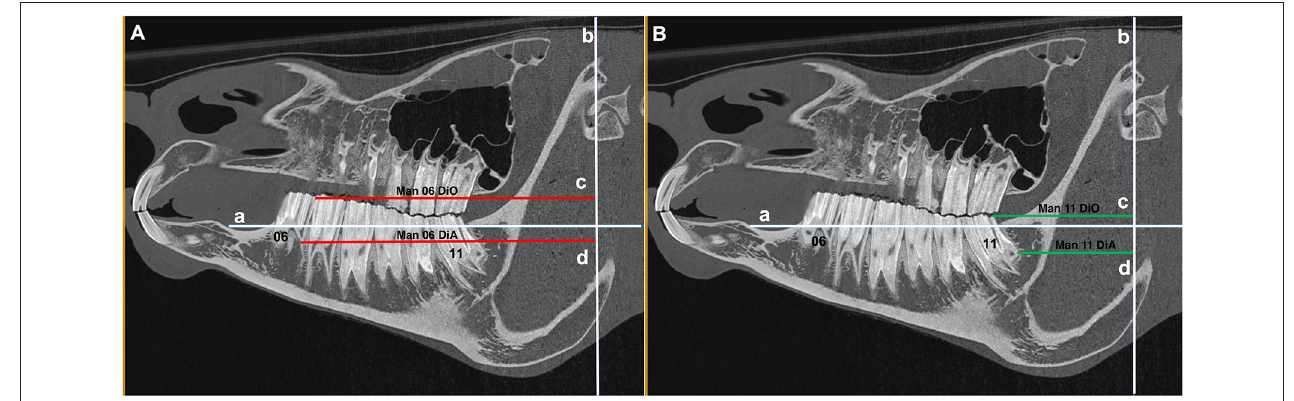
FIGURE 2 | (A) Sagittal CT image of an equine head showing line “a” that intersects the dorsal aspect of the mandibular bone immediately mesial to the mandibular second premolar (Triadan 06) tooth and the dorsal aspect of the mandibular bone immediately distal to the mandibular third molar (Triadan 11) tooth and line “b” at the level of the rostral aspect of the mandibular condyle that lies perpendicular to line “a.” The red lines “c” (Man 06 DiO) and “d” (Man 06 DiA) run from the line “b” to the distal aspect of the occlusal surface of Triadan 06 and to the distal aspect of the apex of Triadan 06, respectively. (B) Sagittal CT image of an equine head showing line “a” that intersects the dorsal aspect of the mandibular bone immediately mesial to the mandibular second premolar (Triadan 06) tooth and the dorsal aspect of the mandibular bone immediately distal to the mandibular third molar (Triadan 11) tooth and line “b” at the level of the rostral aspect of the mandibular condyle that lies perpendicular to line “a.” The green lines “c” (Man 11 DiO) and “d” (Man 11 DiA) run from the line “b” to the distal aspect of the occlusal surface of Triadan 11 and to the distal aspect of the apex of Triadan 11, respectively.